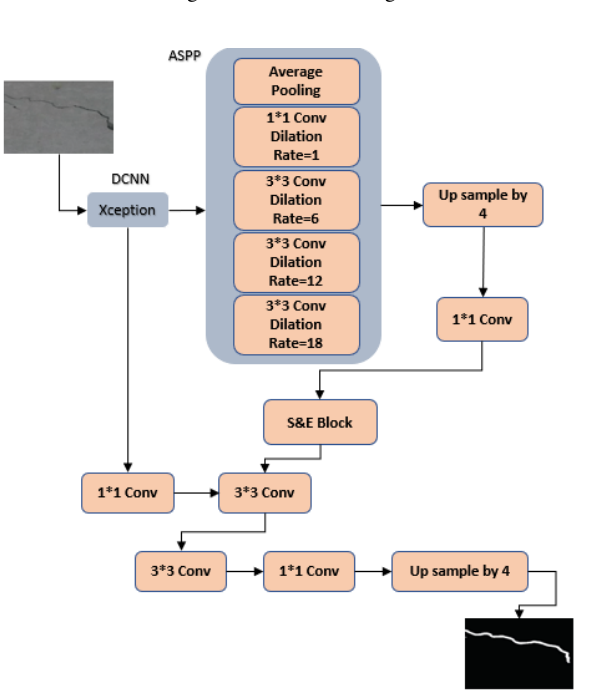
Figure 2. Patchified image.